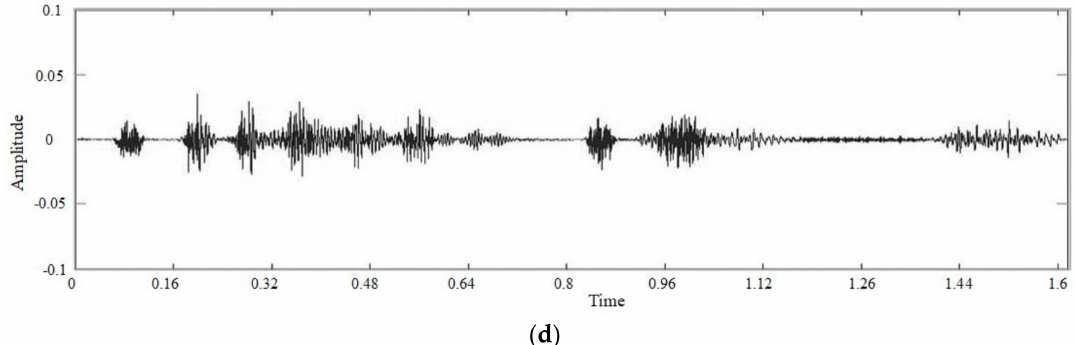
Figure 13. Waveforms. ( a ) Watermarked speech signal; ( b ) Recovered speech signal without processing; ( c ) Four hidden layers, decrement of nodes; ( d ) Four hidden layers, same number of nodes.